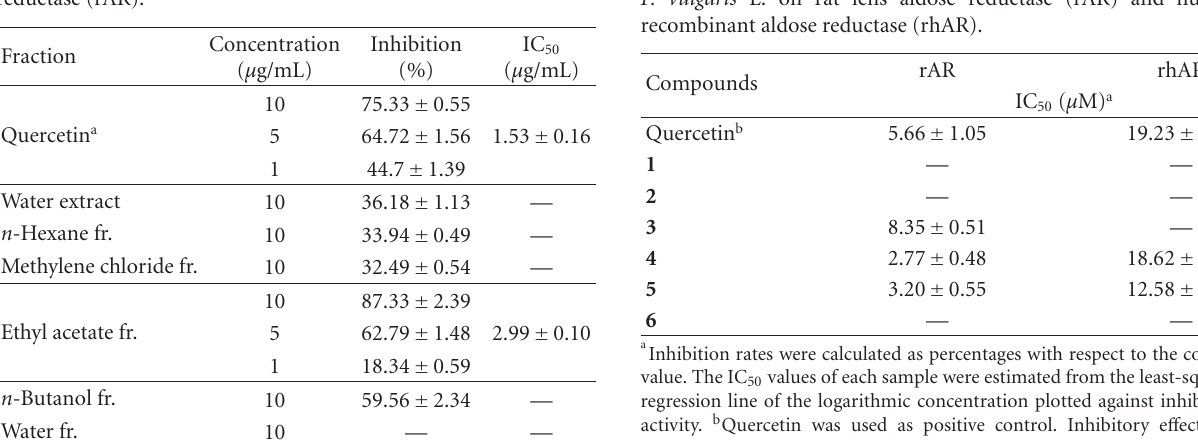
Table 1: Inhibitory e ff ects of the P. vulgaris L. on rat lens aldose reductase (rAR).